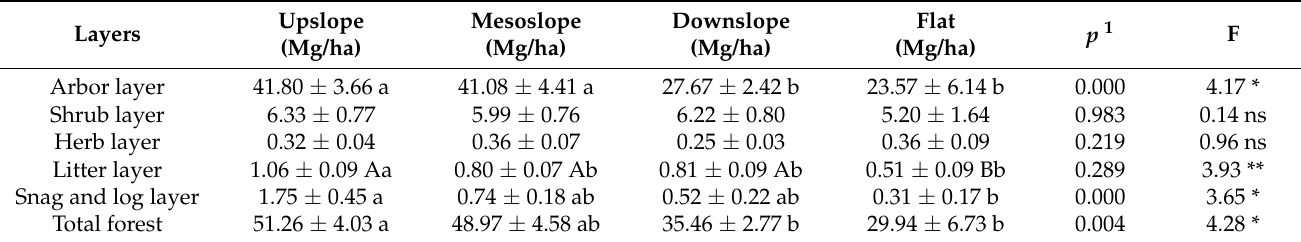
Table 10. Differences in vegetation carbon density (mean ± SE) between slope position